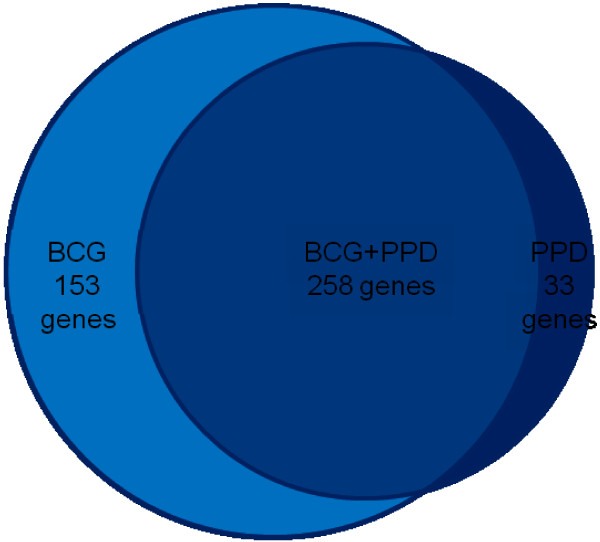
Proportional Venn distribution of genes with a p-value <0.01 expressed in response to either BCG or PPD stimulation. The Venn diagram shows the overlap in gene expression between the 411 genes induced by BCG and 291 genes induced by PPD stimulation.